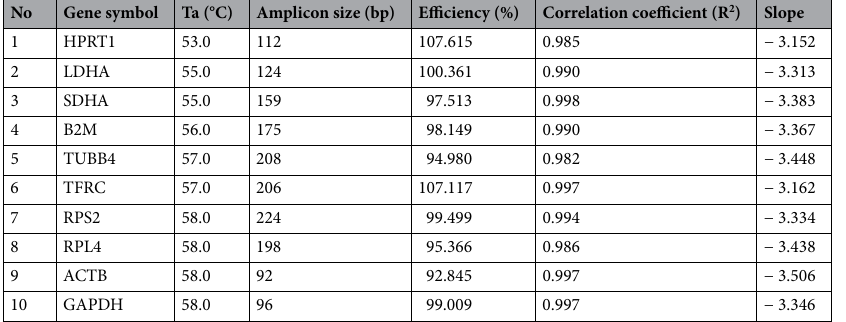
Table 1. Annealing temperature and qPCR efficiency of 10 candidate reference genes. Ta annealing